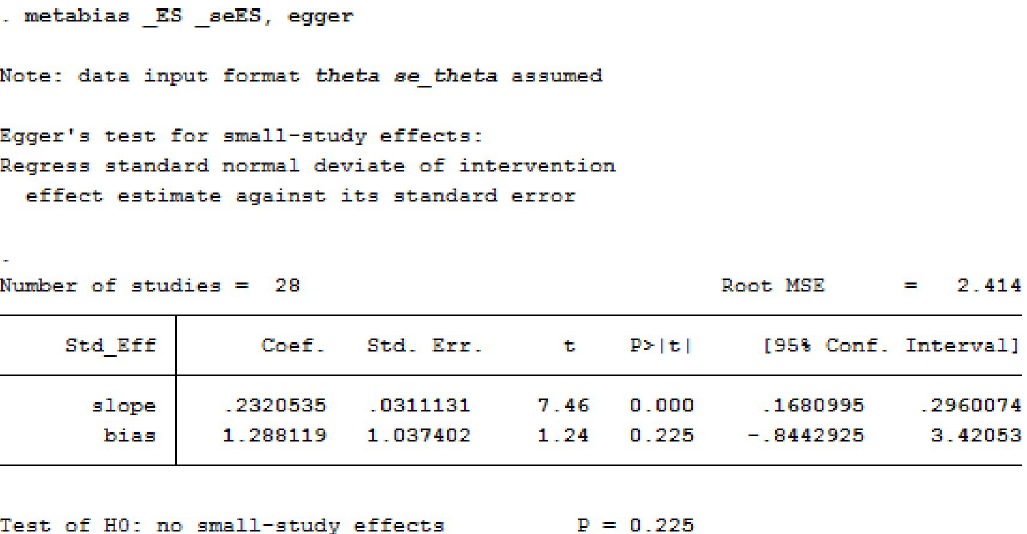
Fig 7. Egger’s test for detection of publication bias for studies included in the prevalence of overweight among adults in Nigeria.